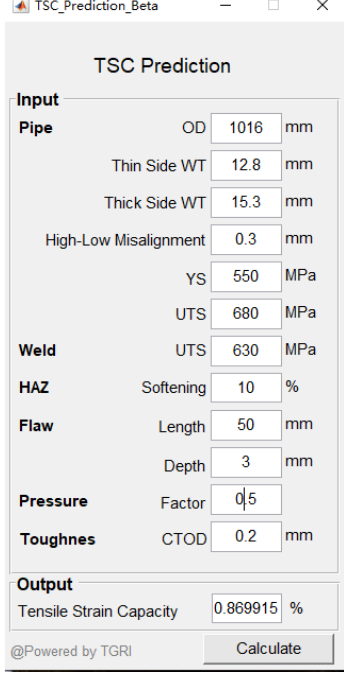
Figure 17. TSC assessment